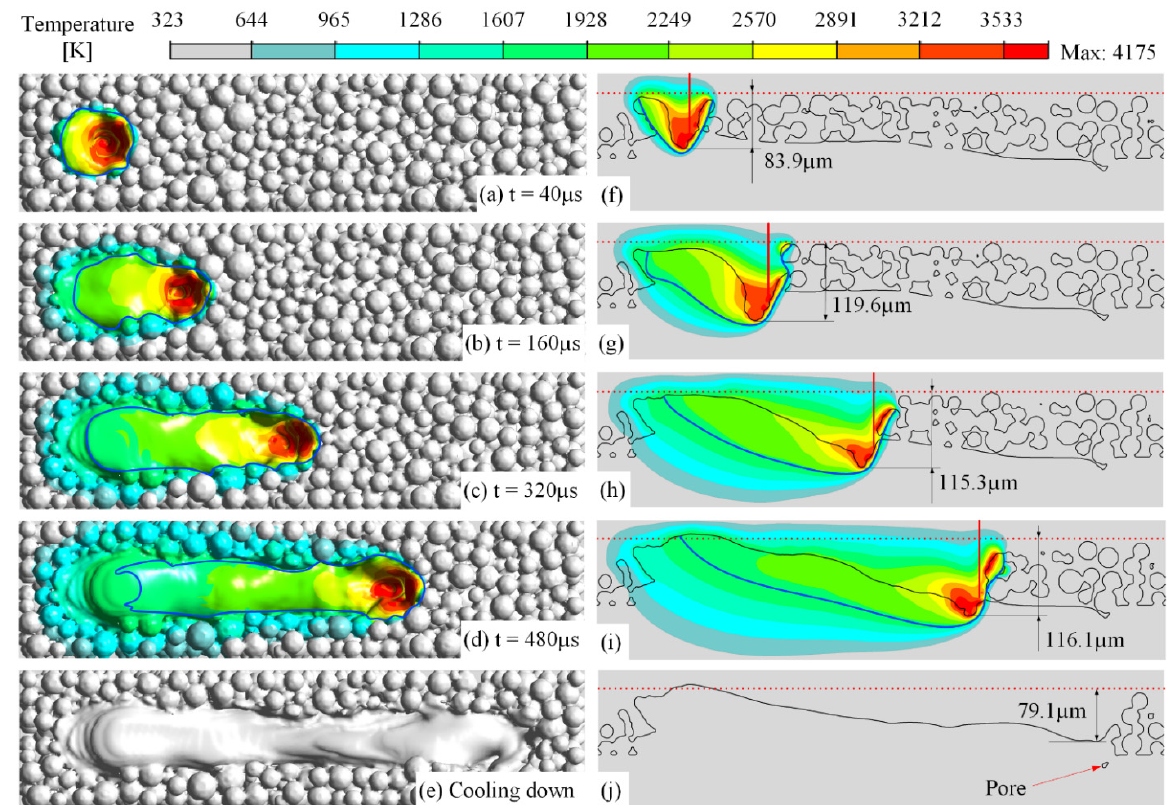
Figure 6. The evolutions of the track morphology and temperature field during the laser scanning on the second layer, where the laser power is 200 W, absorptivity coefficient 0.4, scanning speed 1 m/s, and layer thickness 50 μ m. ( a – d ) the morphology of the track and the temperature field on its surface; ( f – i ) the same on the longitudinal section of the powder bed; ( e , j ) the morphology of the solidified track and the same on the longitudinal section.